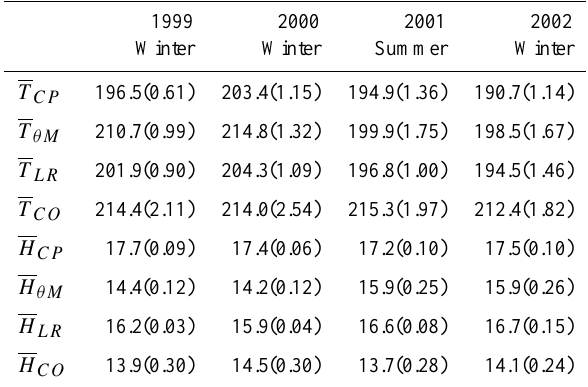
Table 1. The seasonal average tropopause altitudes (in km) and temperatures (in K).The values inside the brackets are the standard